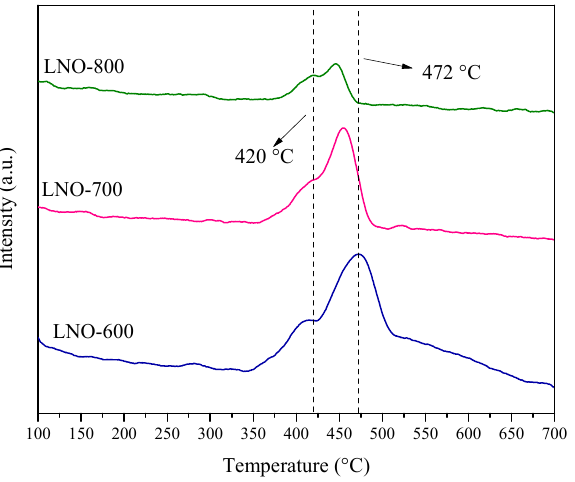
Figure 8. CO-TPD profiles of LaNiO 3 samples synthetized at different temperatures between 600 and 800 °C.